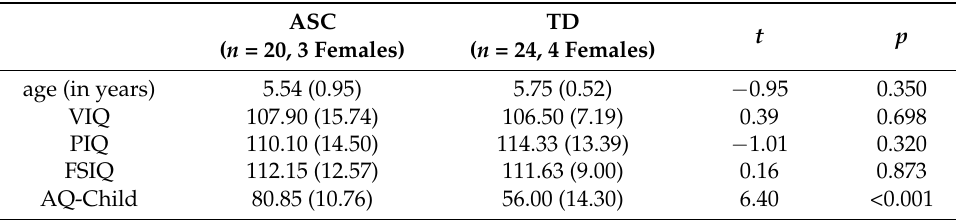
Table 5. Demographics (mean ± SD) of the ASC and TD groups in Experiment